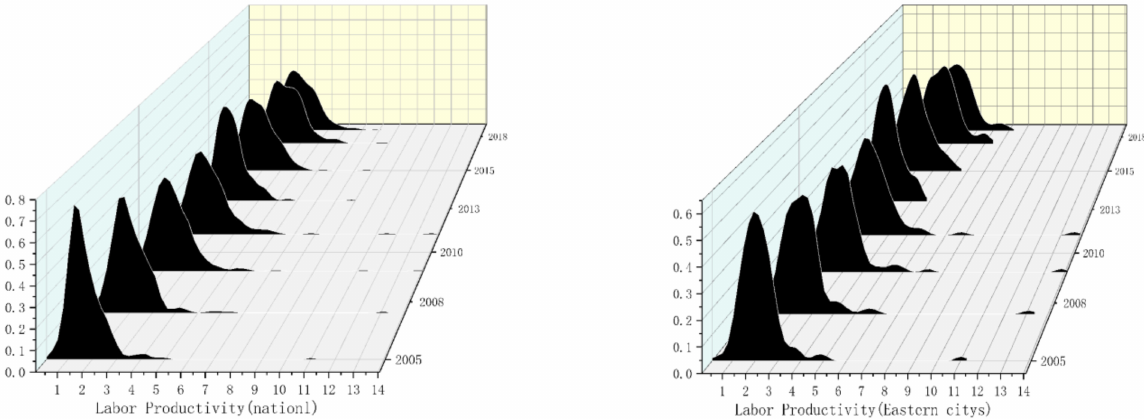
Figure 6. Kernel density of labor productivity in national and eastern cities from 2005 to 2018. Note: the closer the kernel density graph is to the right, the greater the productivity. The higher the kernel density graph, the more concentrated the productivity.